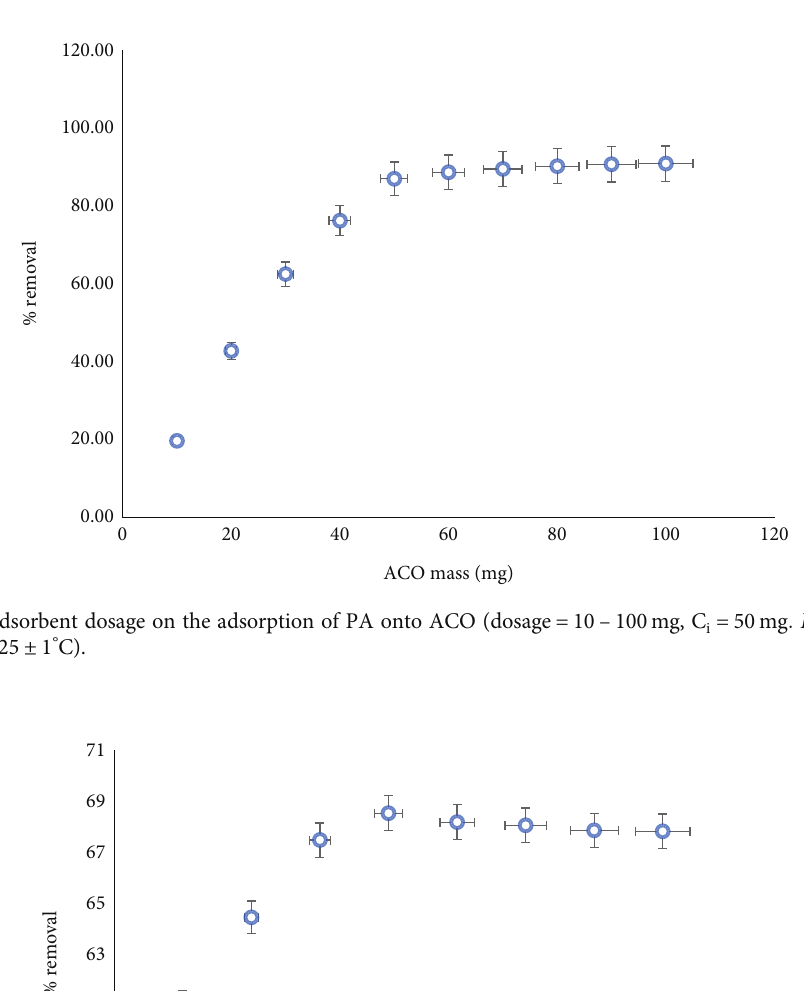
Figure 5: In fl uence of contact time on the adsorption of PA onto ACO ( dosage = 50 mg , C − 120 min , and T = 25 ± 1 °